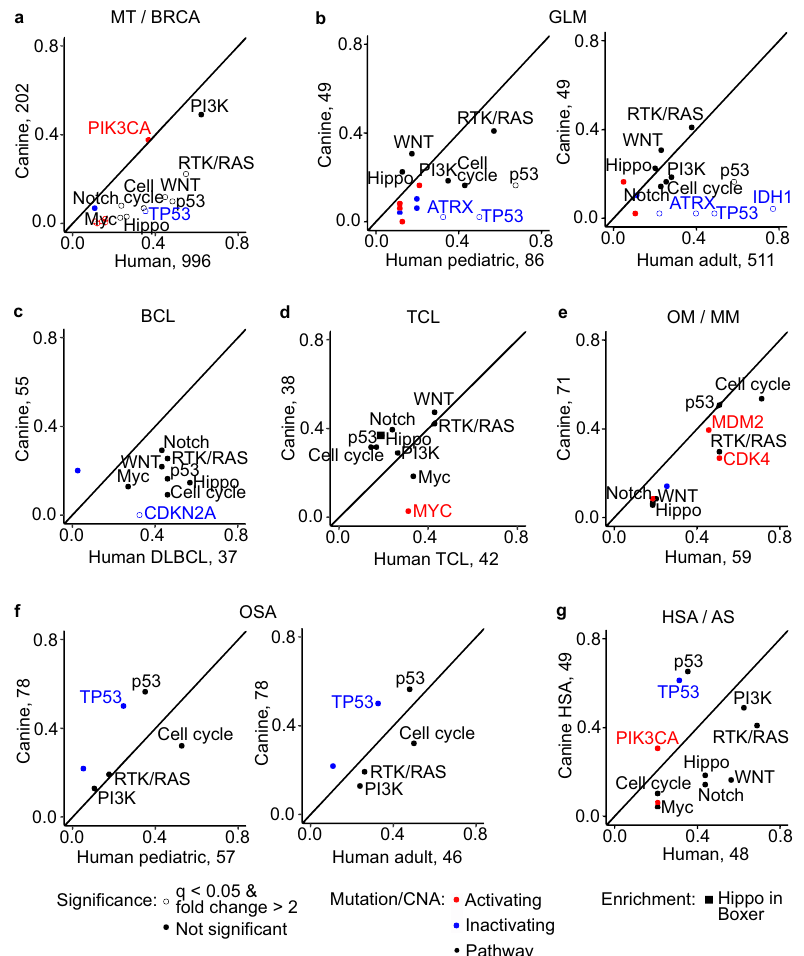
Fig. 4 Canine tumors share many of the same major gene and pathway alterations as their human counterparts. Each panel of a – g compares the mutation recurrence of a gene or pathway in a tumor type between the two species. Human breast cancer (BRCA) ( a ), pediatric and adult GLM ( b ), diffuse large B-cell lymphoma (DLBCL) ( c ), TCL ( d ), mucosal melanoma (MM) ( e ), OSA ( f ) and angiosarcoma (AS) ( g ) are from published studies (see text). Shown are curated pathways (10 total) from a TCGA pan-cancer publication 46 , as well as genes mutated in ≥ 10 tumors and ≥ 10% (for pathway genes) or 20% (for non-pathway genes) of all tumors in a tumor type in either species. Genes and pathways with the mutation frequency that are signi fi cantly different ( q < 0.05 from Fisher exact tests followed by multiple testing correction 60 ) and have ≥ 2-fold changes between the two species are considered different. Source data are provided as a Source Data fi